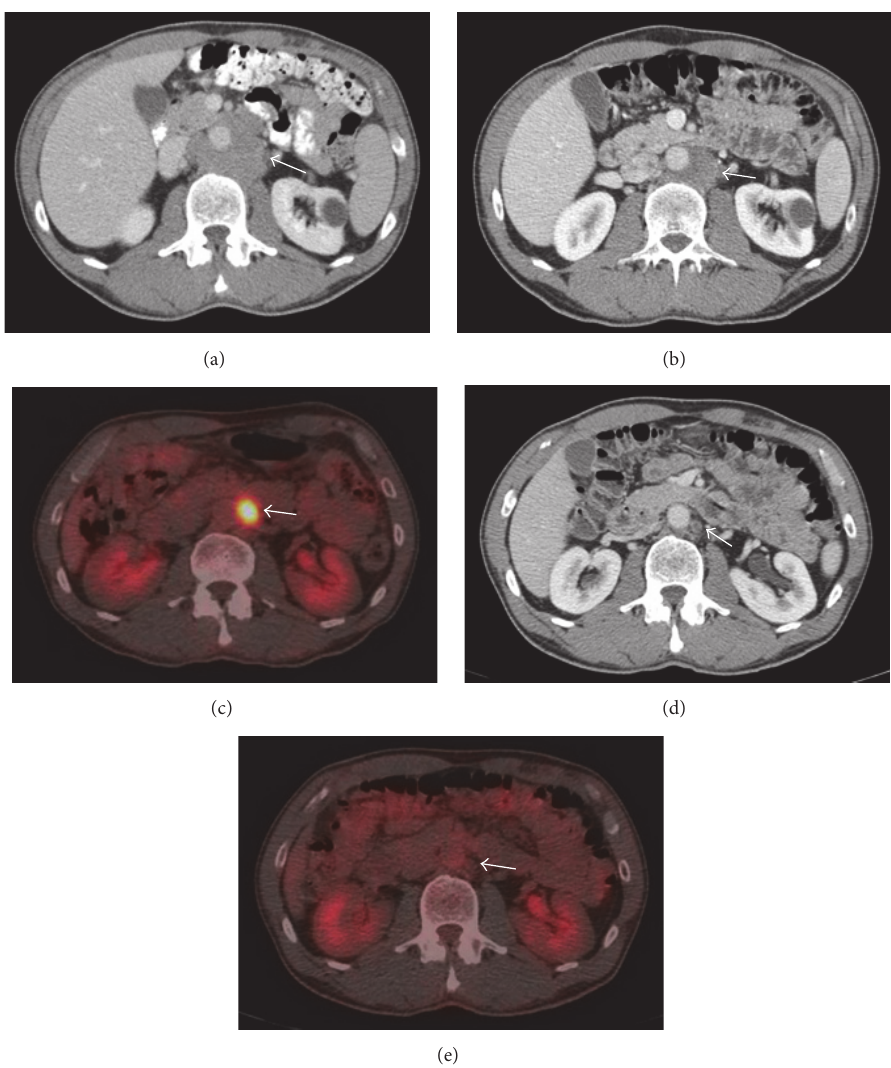
Figure2:Representativeimagesfromserialcomputedtomography(CT)and 18 F-fluorodeoxyglucose-(FDG-)positronemissiontomography (PET) scans showing resolution of the biopsy-proven aggressive B-cell non-Hodgkin lymphoma in a conglomeration of periaortic lymph nodes. (a) CT image prior to diagnosis. (b and c) CT and FDG-PET images (resp.) at time of diagnosis showing interval decrease in size of the mass. (d and e) CT and FDG-PET images (resp.) six months after initial diagnosis, showing resolution of the mass. Arrows denote the location of the